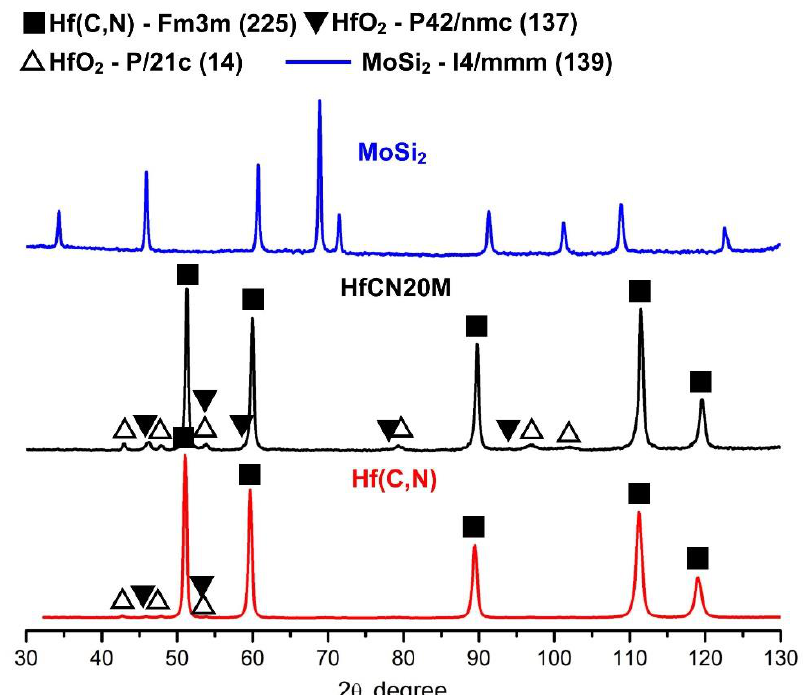
Figure 2. X-ray diffraction patterns of MoSi 2 , Hf(C,N), and HfCN20M samples. Table 1. D-spacing for the bulk Hf(C,N) and Hf(C,N)-MoSi 2.